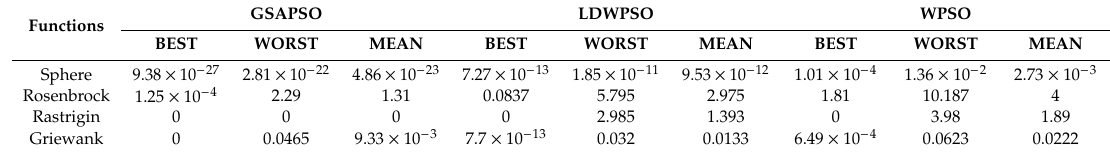
Table 2. Convergence accuracy of GSAPSO, LDWPSO, WPSO algorithms.